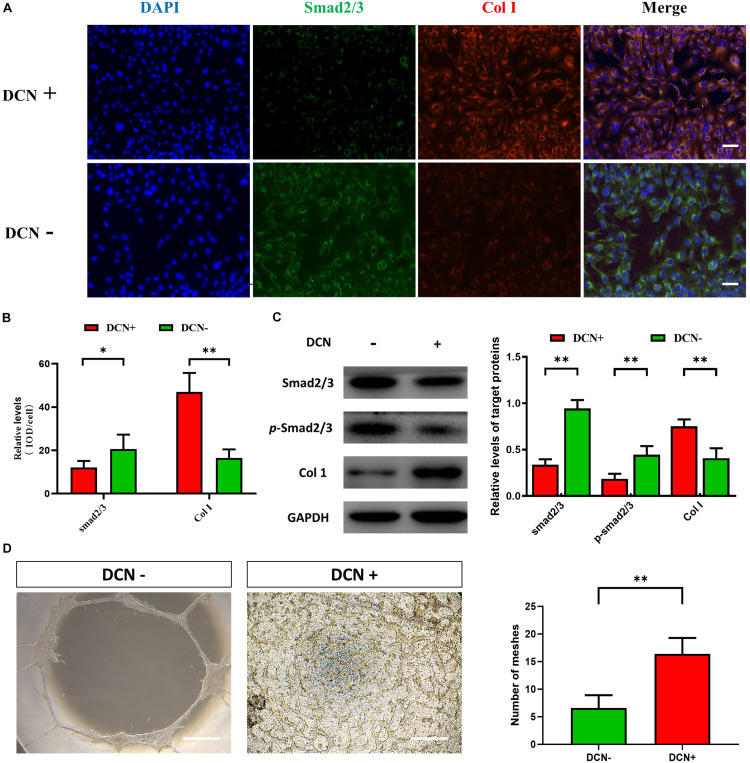
The effect of DCN upregulation on angiogenesis for human umbilical vascular endothelial cells (HUVECs). (A) Immunofluorescence staining for HUVECs with and without DCN treatment. One representative experiment of 3 is shown. The scale bar corresponds to 50 μm. (B) The histograms showed the semiquantitative grading of DCN and Smad 2/3 expression levels by immunofluorescence staining in HUVECs with and without DCN treatment. ∗P < 0.05; ∗∗P < 0.01. (C) Western blot analysis of total Smad 2/3, phosphorylated Smad 2/3 (p-Smad 2/3), and Col I in HUVECs with and without DCN treatment. One representative experiment of 3 is shown. The histograms showed the semiquantitative grading of total Smad 2/3, p-Smad 2/3, and Col I expression levels in HUVECs with and without DCN treatment. ∗∗P < 0.01. (D) Tube formation assays after different treatment. The scale bar corresponds to 50 μm. One representative experiment is shown. ∗∗P < 0.01.